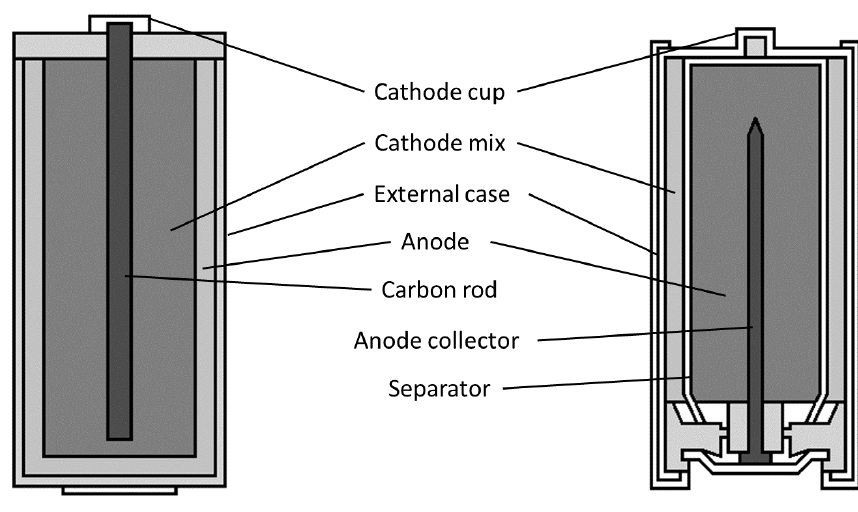
Figure 1. Scheme of Zn-C and alkaline battery [8].